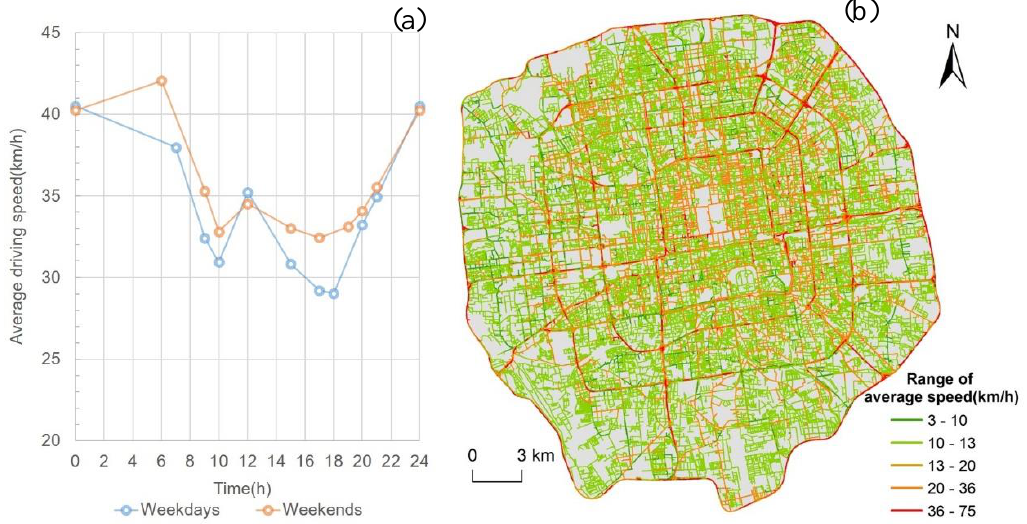
Figure 3. The average vehicle speed: ( a ) at different times; ( b ) on each road segments.